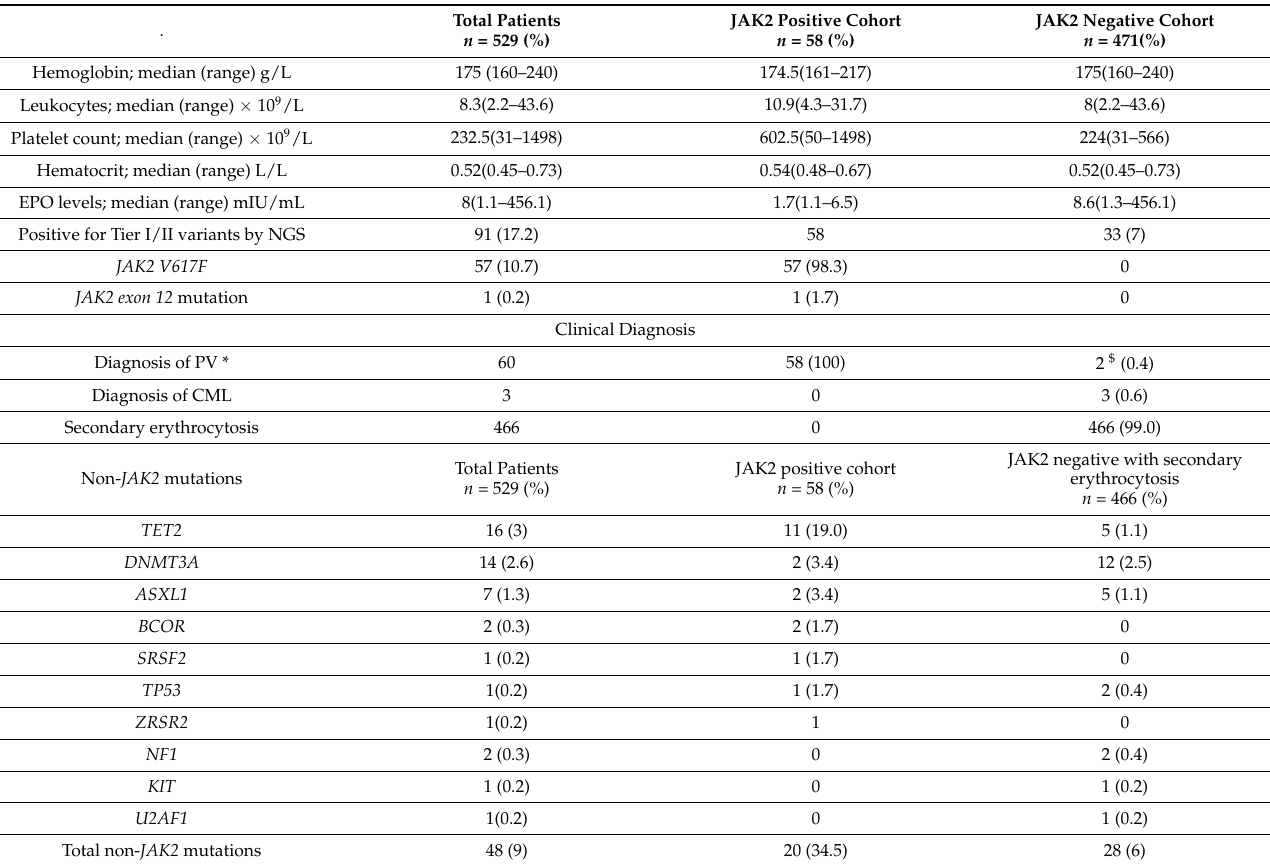
Table 2. Mutations identified in JAK2 positive and negative cohorts.